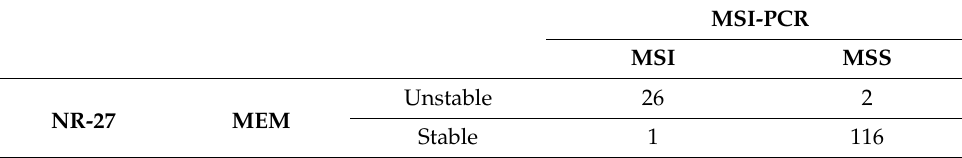
Table 3. Concordance between MEM results for NR-27 and MSI status in MSI-PCR.